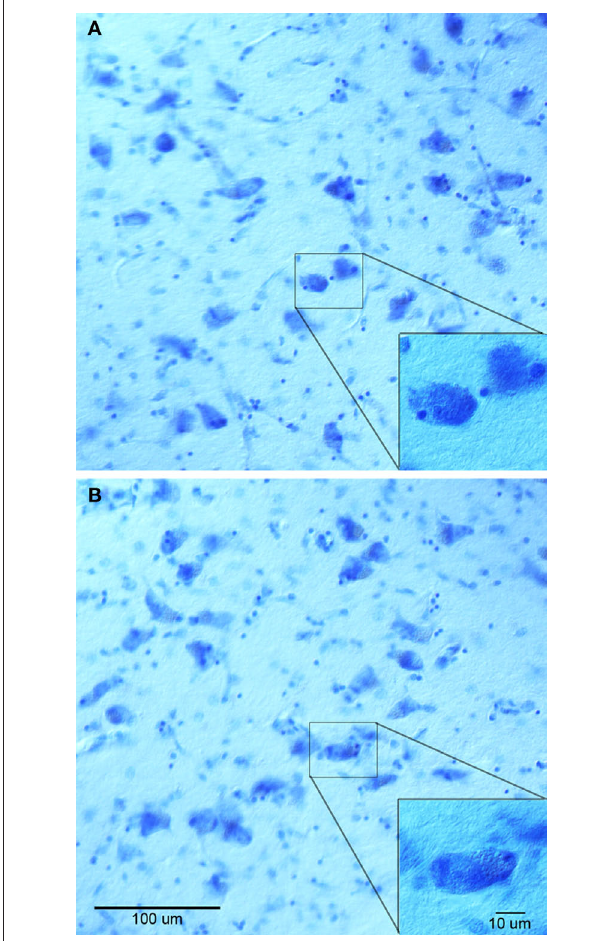
Figure 4 | Nissl stained sections from anterior thalamus treated with gadolinium (A) and non-treated (B). Both (A, B) and insets show similar staining, although stereological neuronal estimates were different.